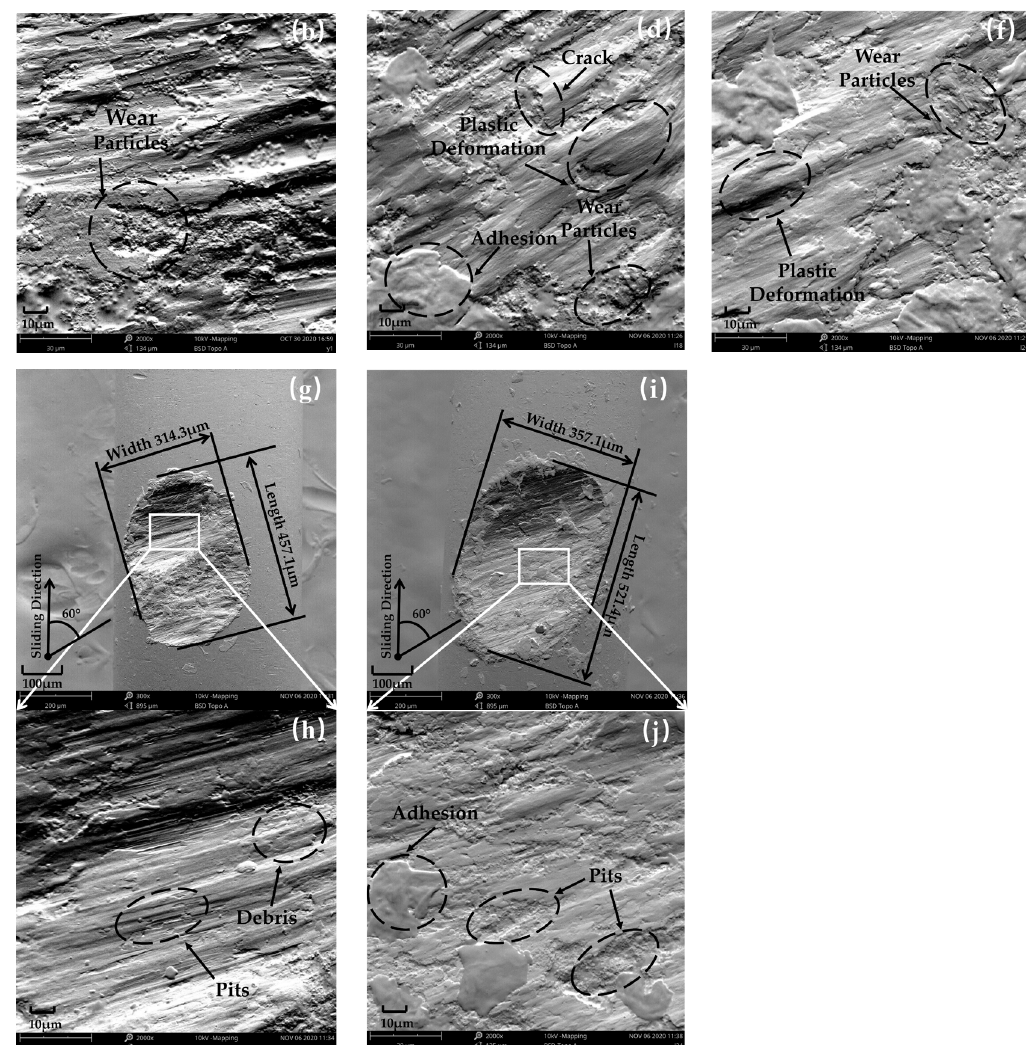
Figure 3. SEM morphology of worn surface of 20~400 °C in group 1: ( a , b ) 20 °C; ( c , d ) 100 °C; ( e , f ) 200 °C; ( g , h ) 300 °C; ( i,j ) 400 °C.